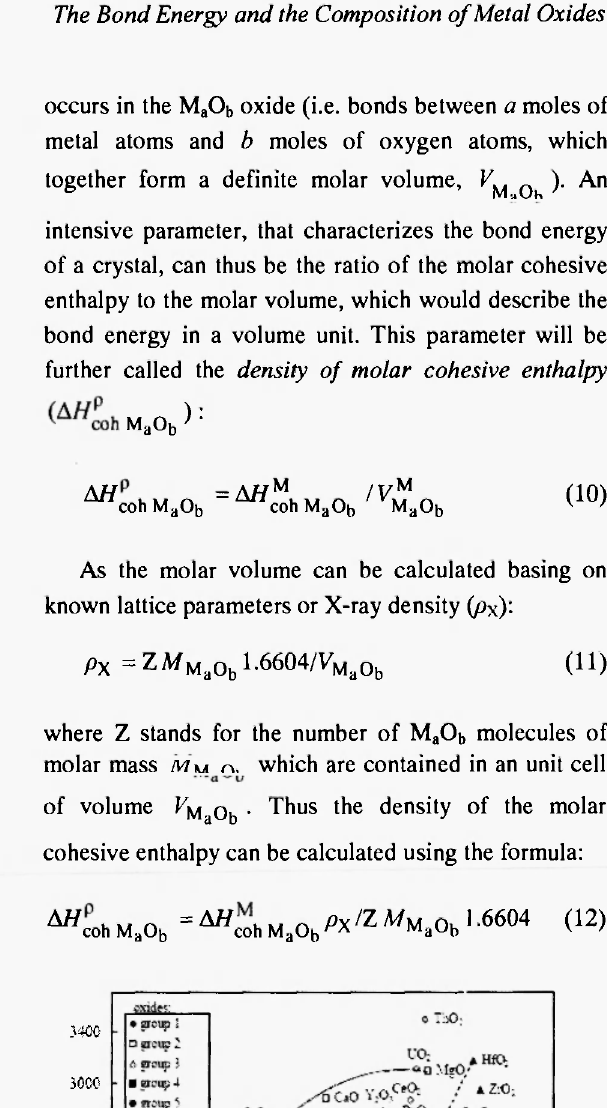
Fig. 4: The relation between the melting temperature of oxides and their effective cohesive